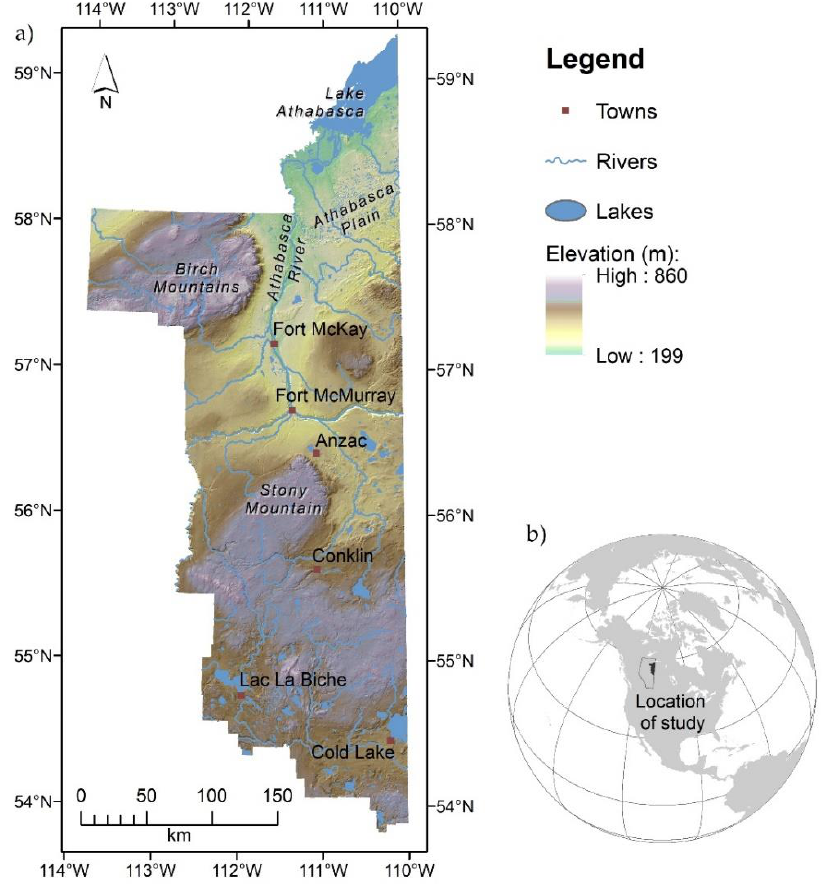
Figure 2. Terrain, elevation, major water features, and towns within the study area ( a ); and location of Alberta, Canada (outline) and study area (gray polygon) within North America ( b ).